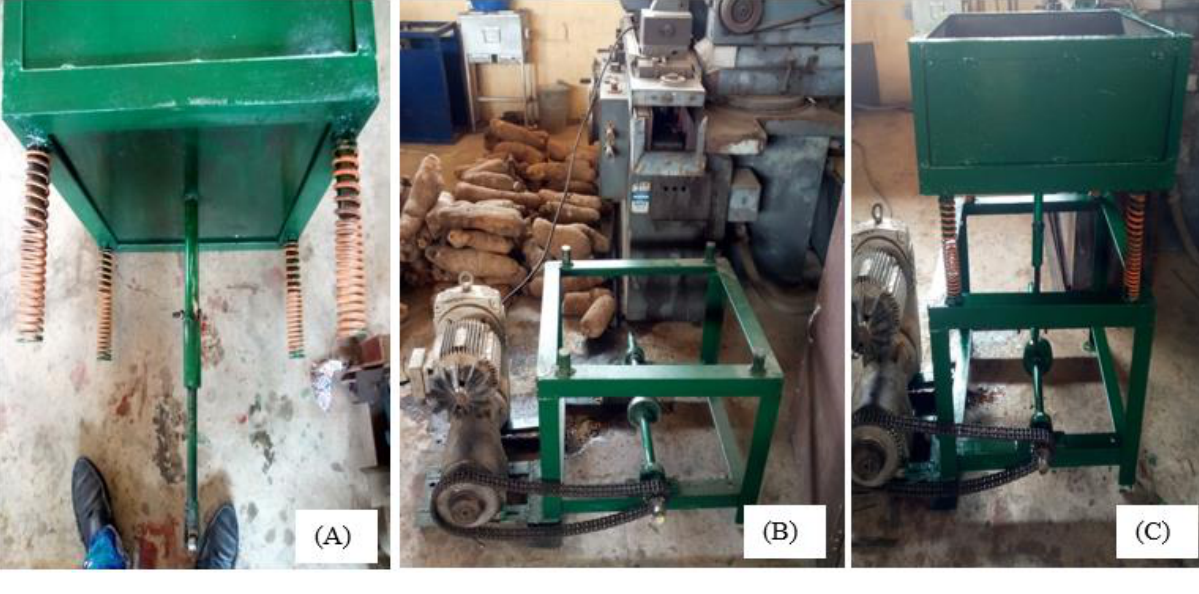
Figure 3. (A) View of the vibrating chamber with the follower rod and roller (B) View of the frame and one of the cams mounted on the shaft (C) View of the assemble vibrating chamber with the frame of the